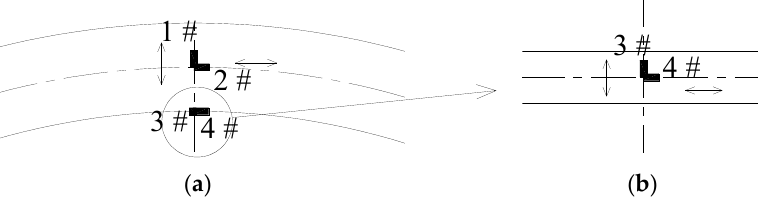
Figure 7. Strain gauges affixed on top arch: ( a ) two groups in web and flange; ( b ) two gauges in the flange.